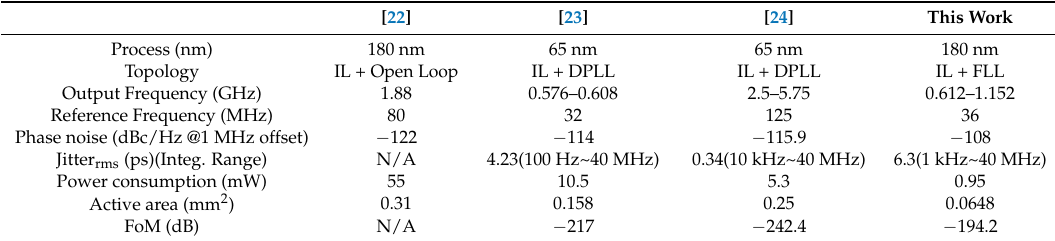
Table 1. Performance Comparison of Injection-Locked Frequency Multiplier